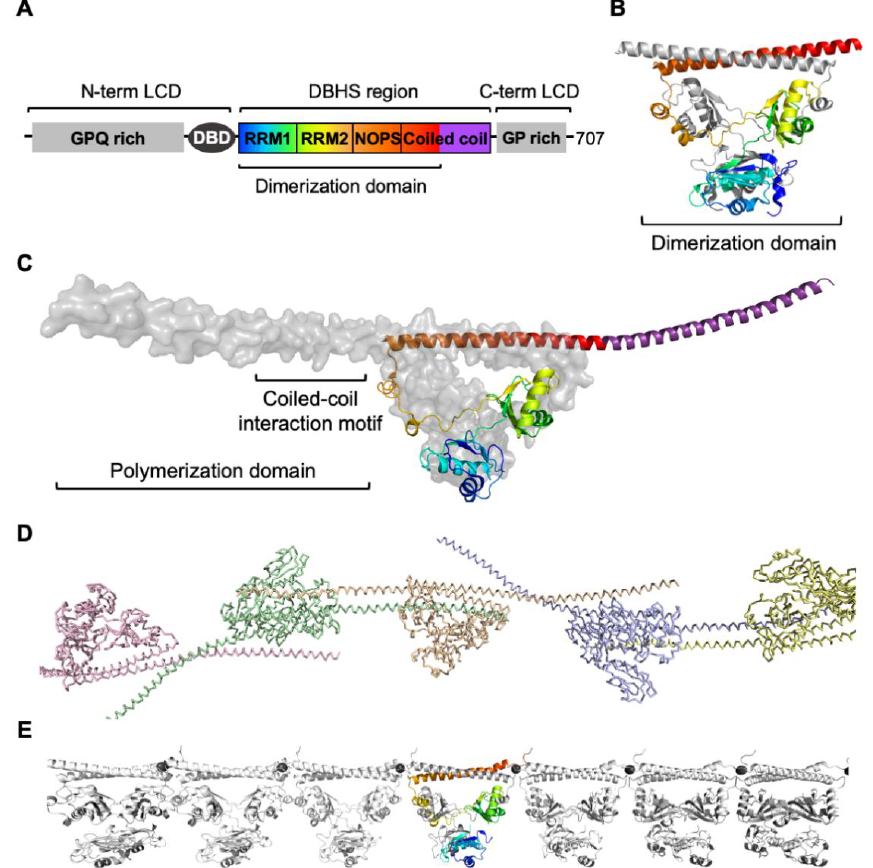
Figure 1. Crystal structures of human splicing factor proline- and glutamine-rich (SFPQ). ( A ) Schematic domainorganizationofhumanSFPQ(majorisoform, SFPQ-A). The conserved Drosophila behavior /